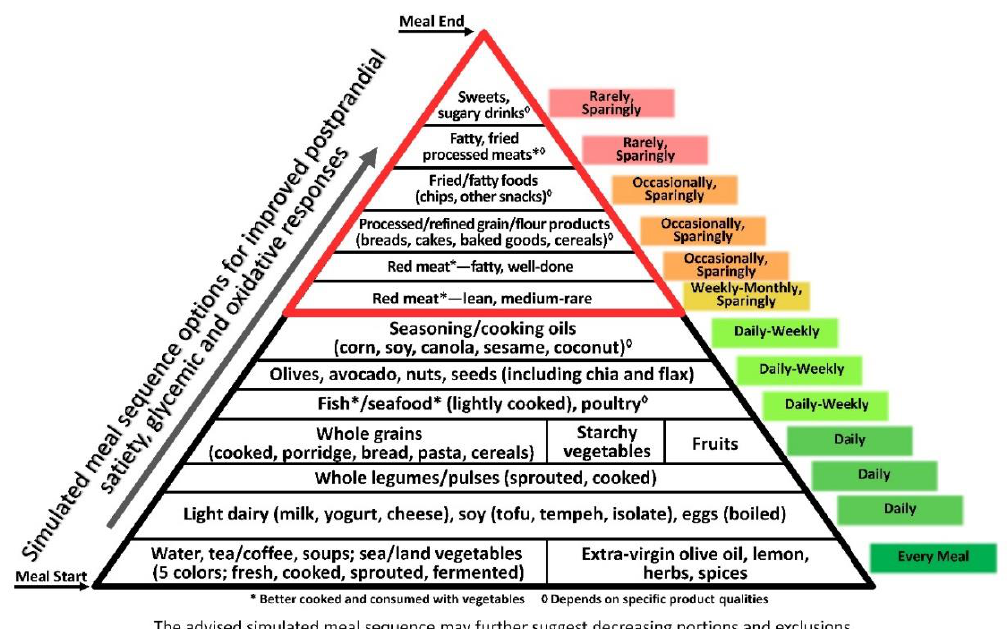
Figure 4. Figure 4. The composite Healthy Meal Sequence Pyramid per Satiety, Glycaemic, and Oxidative Responses. It provides a composite ranking of foods in the meal and recommended frequency of incorporation into diet and lifestyle, per their combined e ff ects on satiety, glycaemic, and oxidative responses. Foods at the bottom of the pyramid are those minimizing the three response axes, and are recommended to start each meal, to protect the body from cumulative deleterious responses from ensuing courses. Foods at the next several levels generate minimal-to-moderate responses and continue to contribute protection; and foods at the top levels of this pyramid are recommended to be either avoided or used only sparingly / occasionally, and preferably at the end of the meal, when the body has been primed against hunger-driven overconsumption and sharp GR and